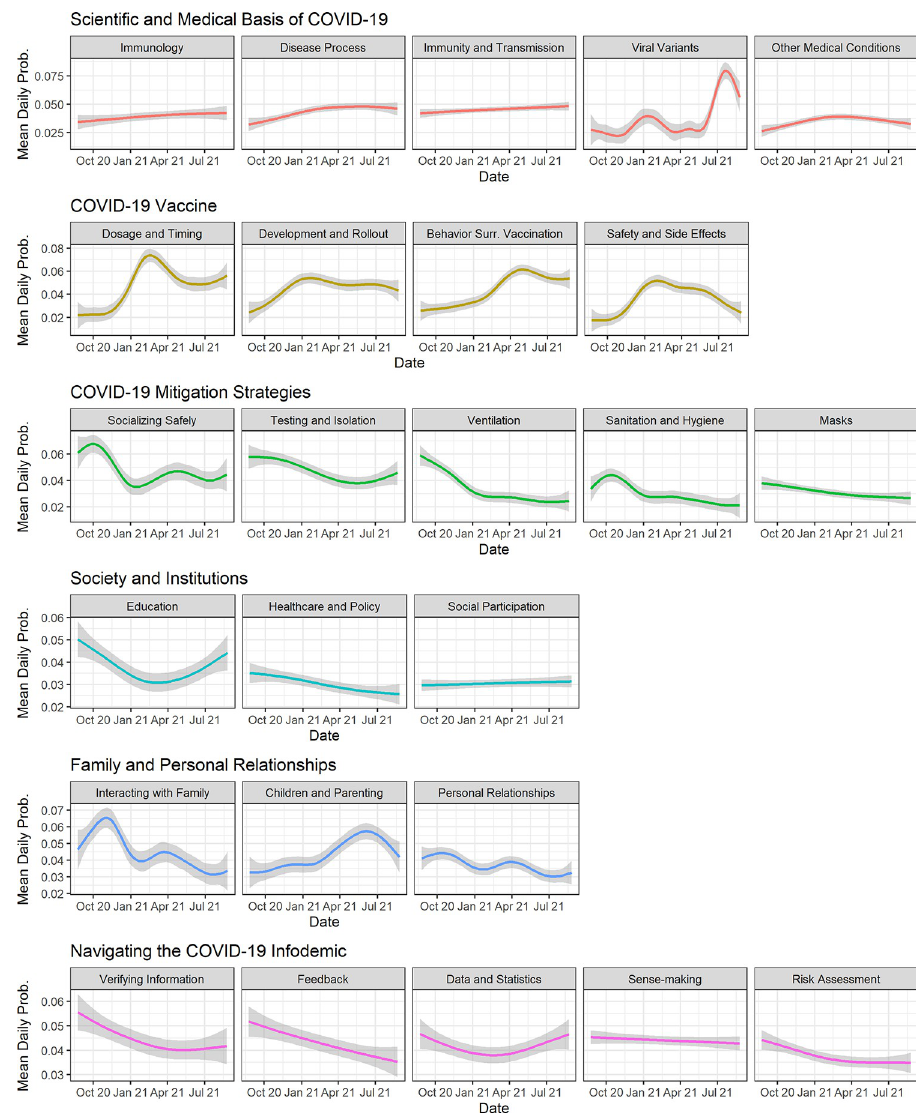
Fig 2. Trends in topic prevalence from August 24, 2020 to August 24,